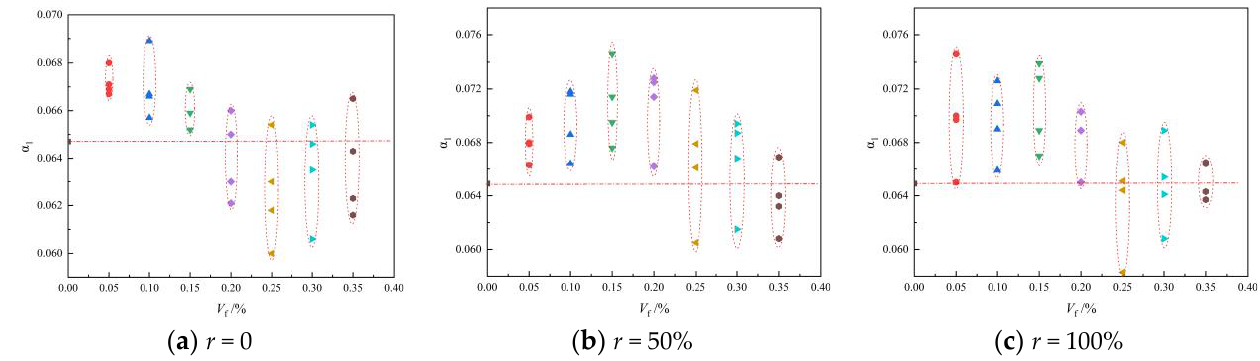
Figure 9. Scatter diagram of BFRAC tension compression ratio under different recycled coarse aggregate replacement rates.